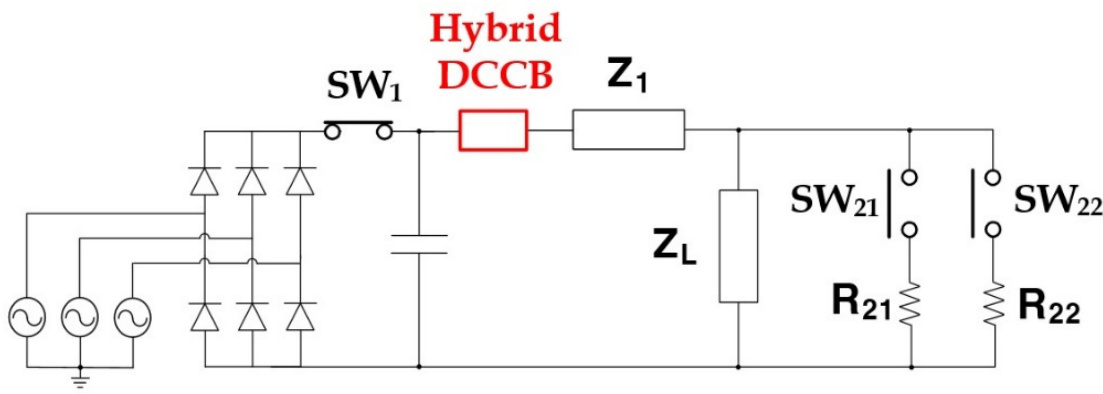
Figure 2. Simulated DC system for the operation of hybrid DCCB using double quench; Z 1 : line impedance; Z L : load impedance; R 21 : small DC fault resistance; R 22 : large DC fault resistance. Table 1. Specification of DC System for DC Short-Circuit Tests.